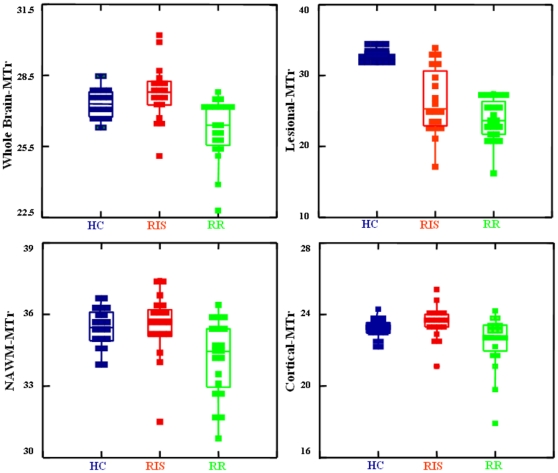
MTr in HC, RIS and RRMS.Box plots comparing the MTr measures of HC (left), RIS subjects (center) and RRMS patients (right). Values are relative to whole brain-MTr (top left), lesional-MTr (top right), NAWM-MTr (bottom left) and cortical-MTr (bottom right). Note the differences between the three groups, with generally higher MTr values in RIS subjects than in RRMS patients. See text for abbreviations.